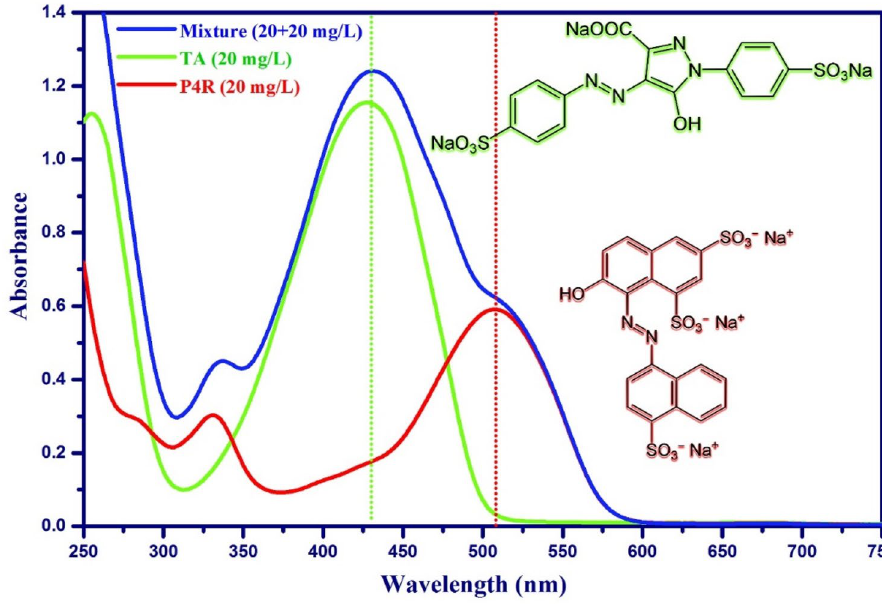
Figure 1. The representative UV–V is spectra (zero-order derivative) for TA, P4R, and mixture of dyes with related chemical structures.